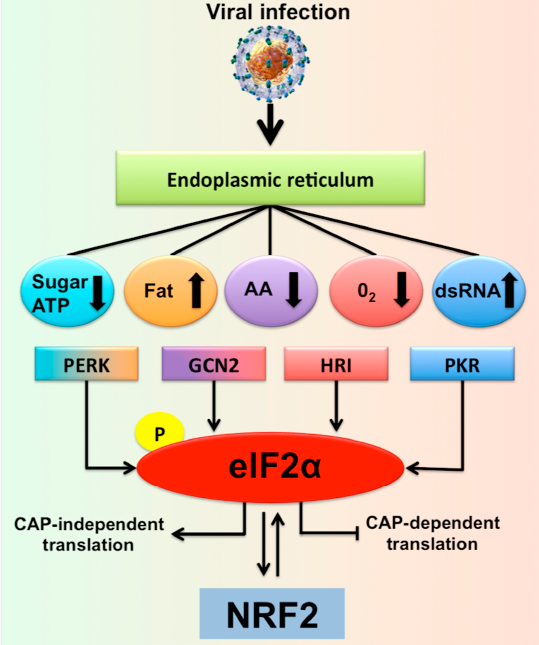
Figure 1. Hepatic adaptive response to multifaceted stress generated during chronic hepatitis C virus (HCV) infection is called the integrated stress response (ISR). Shown is the summary of multifaceted stress response generated during chronic HCV infection that is associated with the risk of liver disease progression. In addition to the direct virus-induced ER stress/UPR gene expression, many different cellular stress signals are induced in HCV-infected cells due to a shift in host cell metabolism. There are four different stress kinases participate in the generation of multifaceted stress response. Stress signals during HCV infection activate PKR, GCN2, PERK, and HRI kinases that stimulate phosphorylation of eIF2 α , the core element of the stress response, which inhibits cellular translation. Under normal conditions with low levels of phosphorylated eIF2 α promotes cap-dependent translation. During the ISR, cellular translation is attenuated due to increased eIF2 α phosphorylation, which supports the translation of specific gene (ATF4) needed for cell survival. The PERK-eIF2 α -ATF4 activation has been associated with autophagy induction and cell survival. If the stress becomes severe this can also activate NRF2 transcription and chaperone-mediated autophagy (CMA) activation.